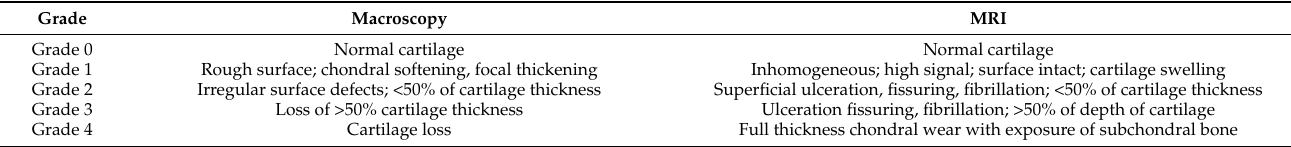
Table 1. Outerbridge classification